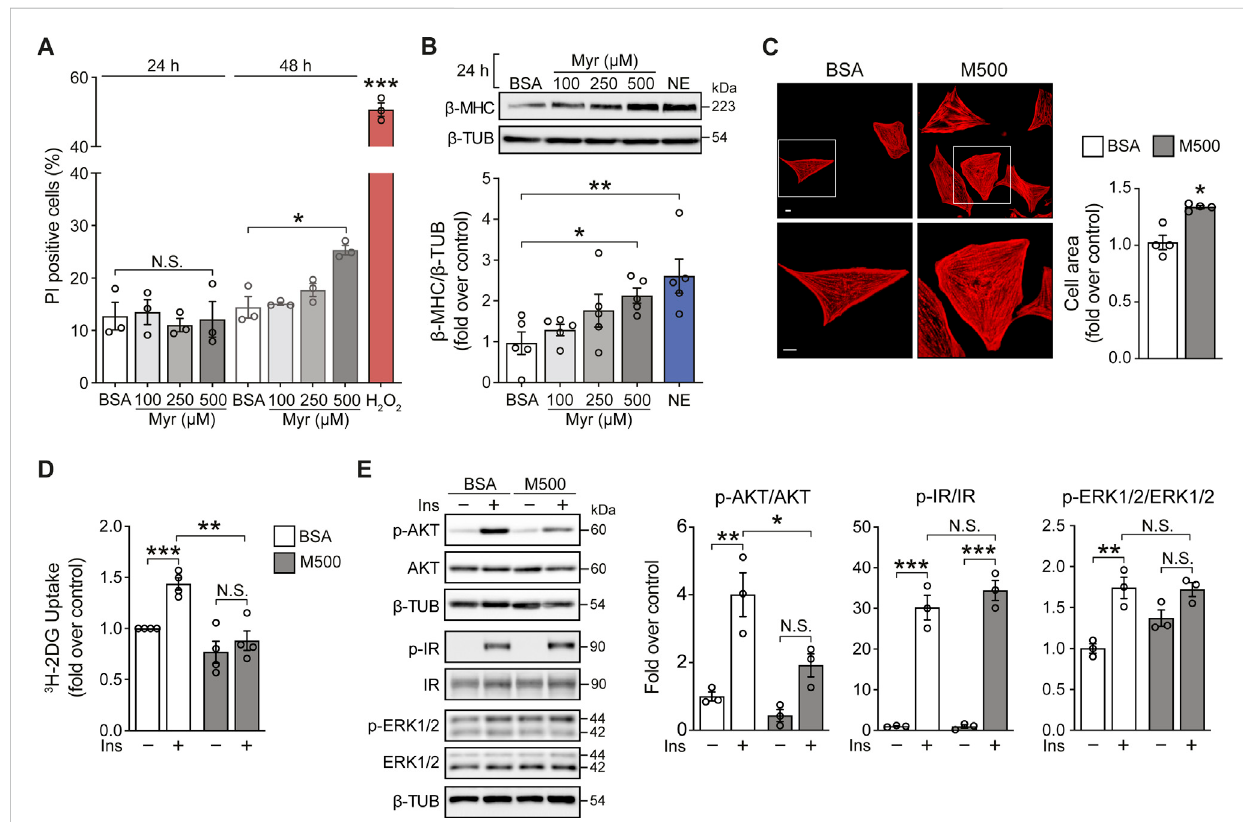
FIGURE 1 Myristate induces cardiomyocyte hypertrophy and insulin desensitization. (A) NRVM were treated with BSA 100 μ M or Myristate (Myr) 100, 250 and 500 μ M,for24and48 h.Totalcelldeathwasevaluatedwithpropidiumiodide(PI)incorporationundernon-permeabilizingconditionsby fl owcytometry (n=3).H 2 O 2 500 μ Mwasusedasapositivecontrolforcelldeath. (B) Top :Representativeimmunoblotof β -MHC,detectedinNRVMtreatedwithMyr100, 250 and 500 μ M, for 24 h. β -TUBULIN ( β -TUB) was used as a loading control. Treatment with norepinephrine (NE) 10 μ M for 24 h, was used as a positive control for cardiomyocyte hypertrophy. Bottom : Quanti fi cation of β -MHC/ β -TUB (n = 5). (C) Top : Representative images of NRVM treated with BSA and myristate 500 μ M (M500) for 24 h and stained with rhodamine-phalloidin to evaluate cell area and Hoeschst nuclear stain. Scale bar: 10 μ m. Bottom :Quanti fi cationofcellarea,from~25NRVMforeachexperimentalcondition(n=4). (D) 3 H-2-deoxyglucose(DG)uptakeofNRVMincubatedwith BSA or M500 for 24 h and stimulated with insulin (Ins) 10 nM for 15 min, or non-stimulated (n = 4). (E) Left : Representative immunoblots of phospho (p)- AKT (Ser473), total AKT, p-IR (Tyr1150/1151), total IR, p-ERK1/2 (Thr202/Tyr204) and total ERK1/2 from NRVM treated with BSA or M500 for 24 h, unstimulated or stimulated with insulin 10 nM for 15 min. β -TUBULIN was used as a loading control. Right : Quanti fi cation of p-AKT/AKT, p-IR/IR and p-ERK1/2/ERK1/2 (n = 3). In all panels: individual data points are shown, and bars represent mean ± S.E.M. Statistical comparisons: * p < 0.05, ** p < 0.01, and *** p < 0.01. N.S: non-signi fi